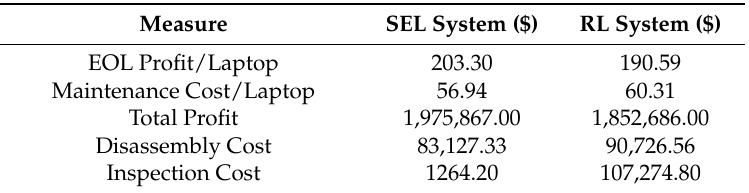
Table 10. Experiment results for SEL and RL